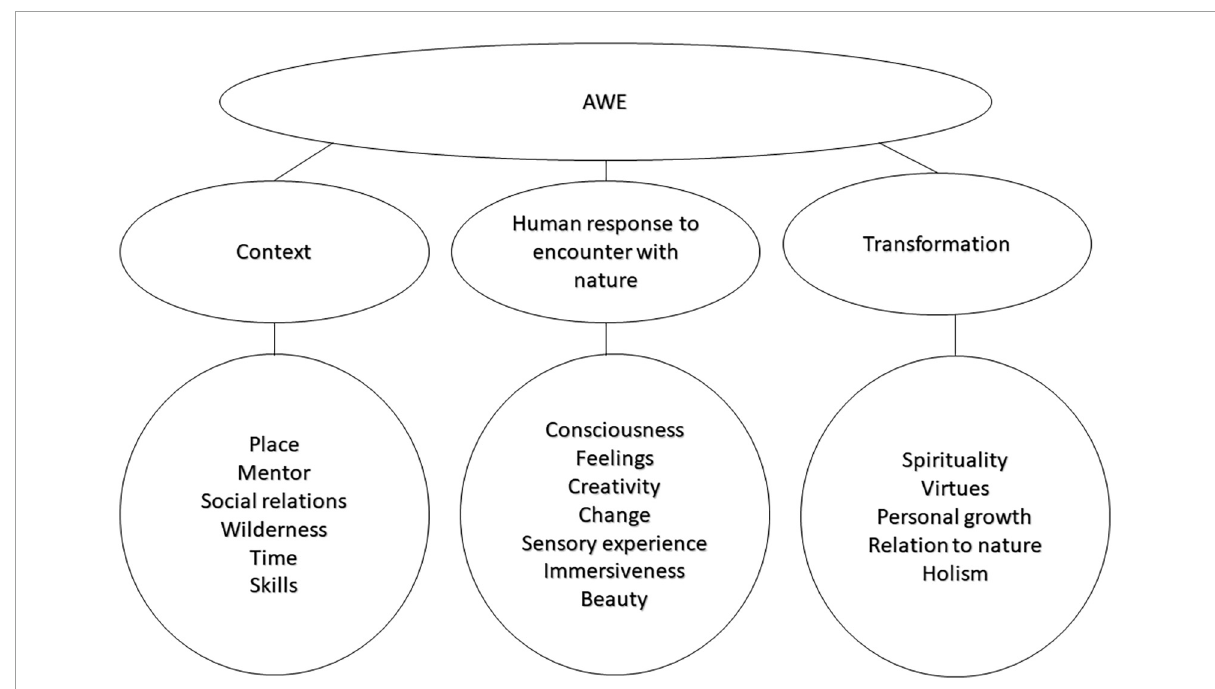
FIGURE1 Main themes and subthemes of awe from Arctic